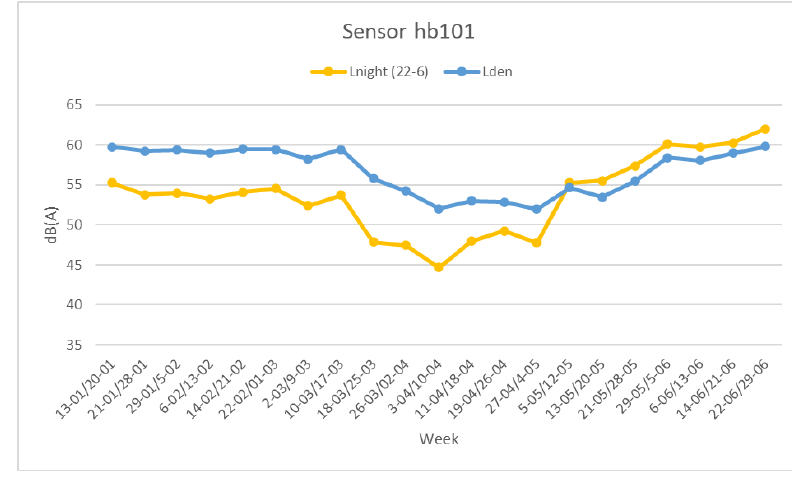
Figure 9: Emphasis on regional and national measures establishment against